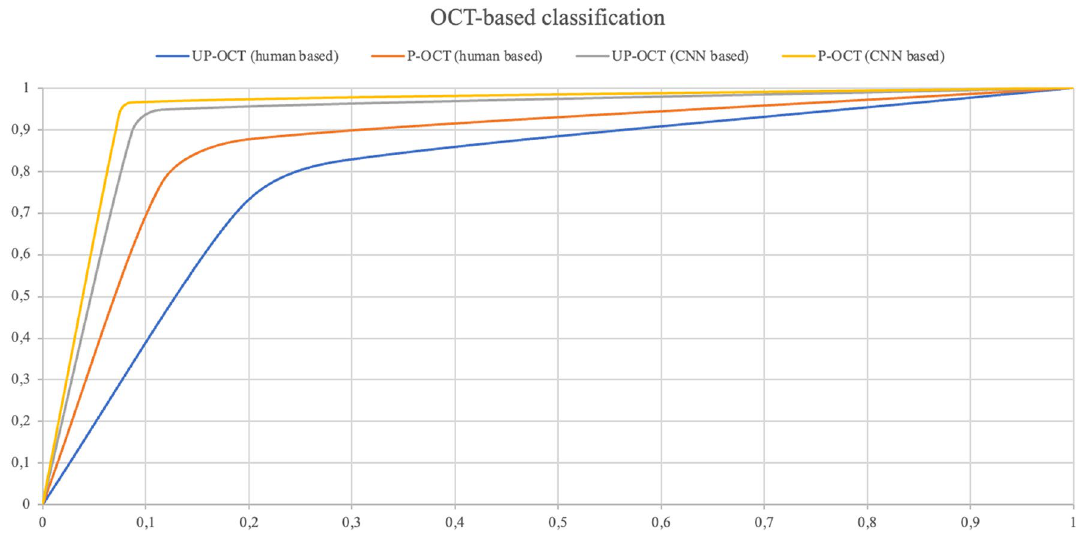
Figure 3. ROC curves illustrating accuracy of the 4 classification methods on OCT images. CNN convolutional neural network; OCT optical coherence tomography, P-OCT processed OCT images, UP-OCT unprocessed OCT images.